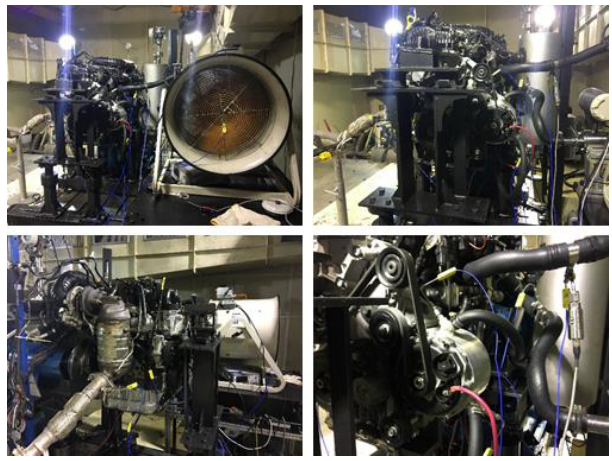
Figure 9. Photo of the engine experimental setup and the test engine. Table 2. Specifications of the diesel engine.